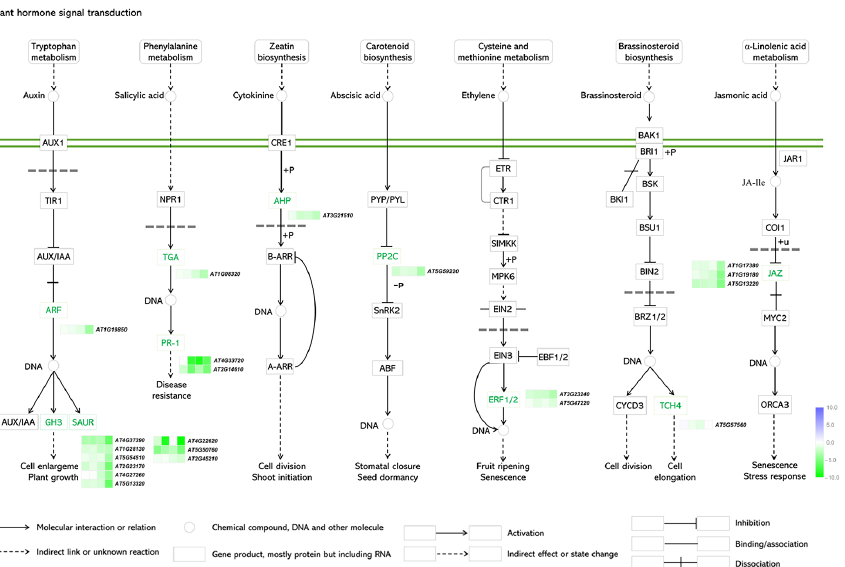
Figure 6. DEGs involved in plant hormone signal transduction pathways. From left to right: auxin (AUX), salicylic acid (SA), cytokinine (CTK), abscisic acid (ABA), ethylene (ETH), brassinosteroid (BR), and jasmonic acid (JA). In heatmap, each column represents log 2 (from left to right: ChWT-8 hpi vs. Chatg8 Δ-8 hpi, ChWT-22 hpi vs. Chatg8 Δ-22 hpi, ChWT-40 hpi vs. Chatg8 Δ-40 hpi, and ChWT-60 hpi vs. Chatg8 Δ-60 hpi) and each row represents a gene. Expression values are presented as log2 fold change (purple represents up-regulation; green represents down-regulation.